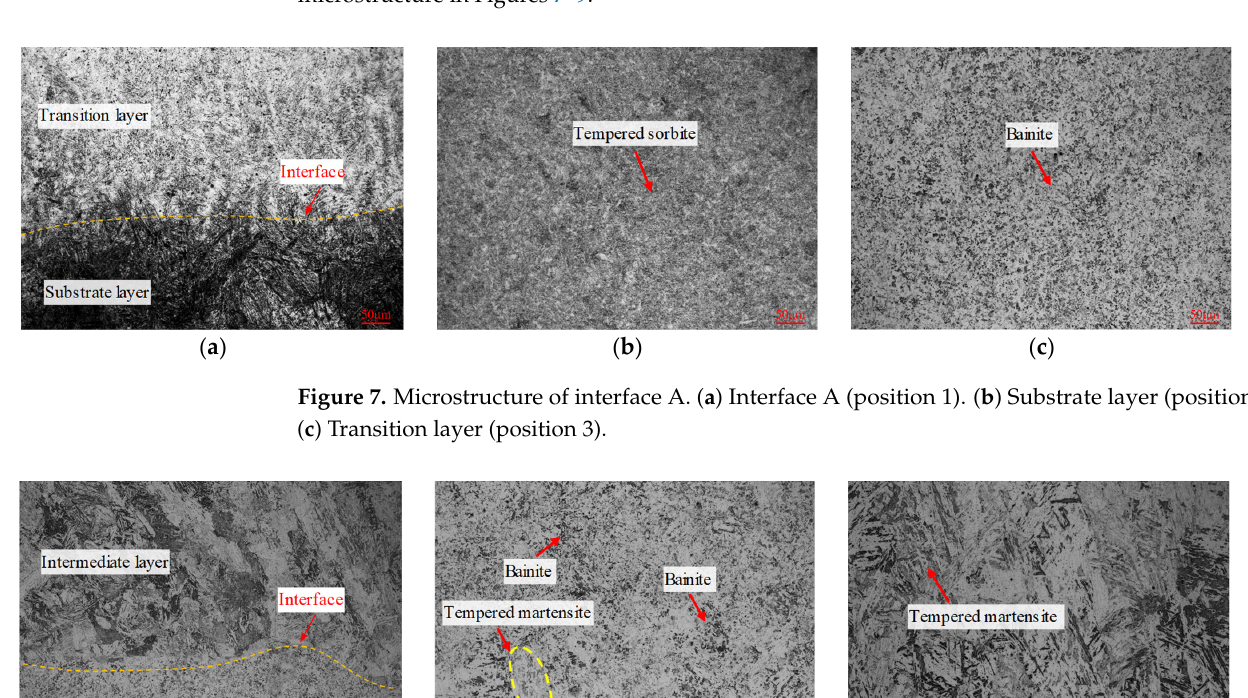
Figure 7. Microstructure of interface A. ( a ) Interface A (position 1). ( b ) Substrate layer (position 2). ( c ) Transition layer (position 3).